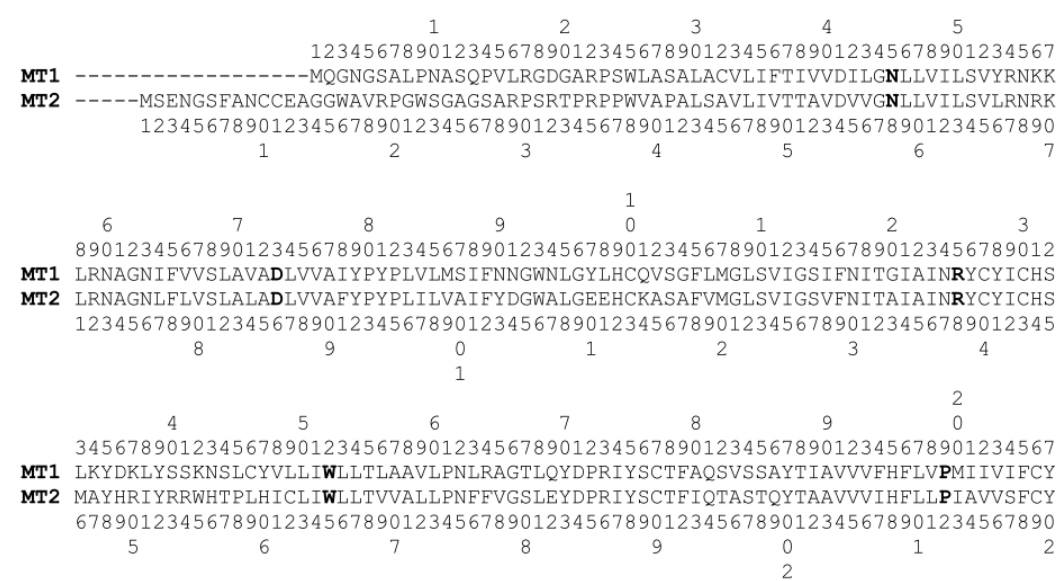
Figure 2. Amino acid sequences of human MT positions X.50 of each transmembrane helix are indicated in